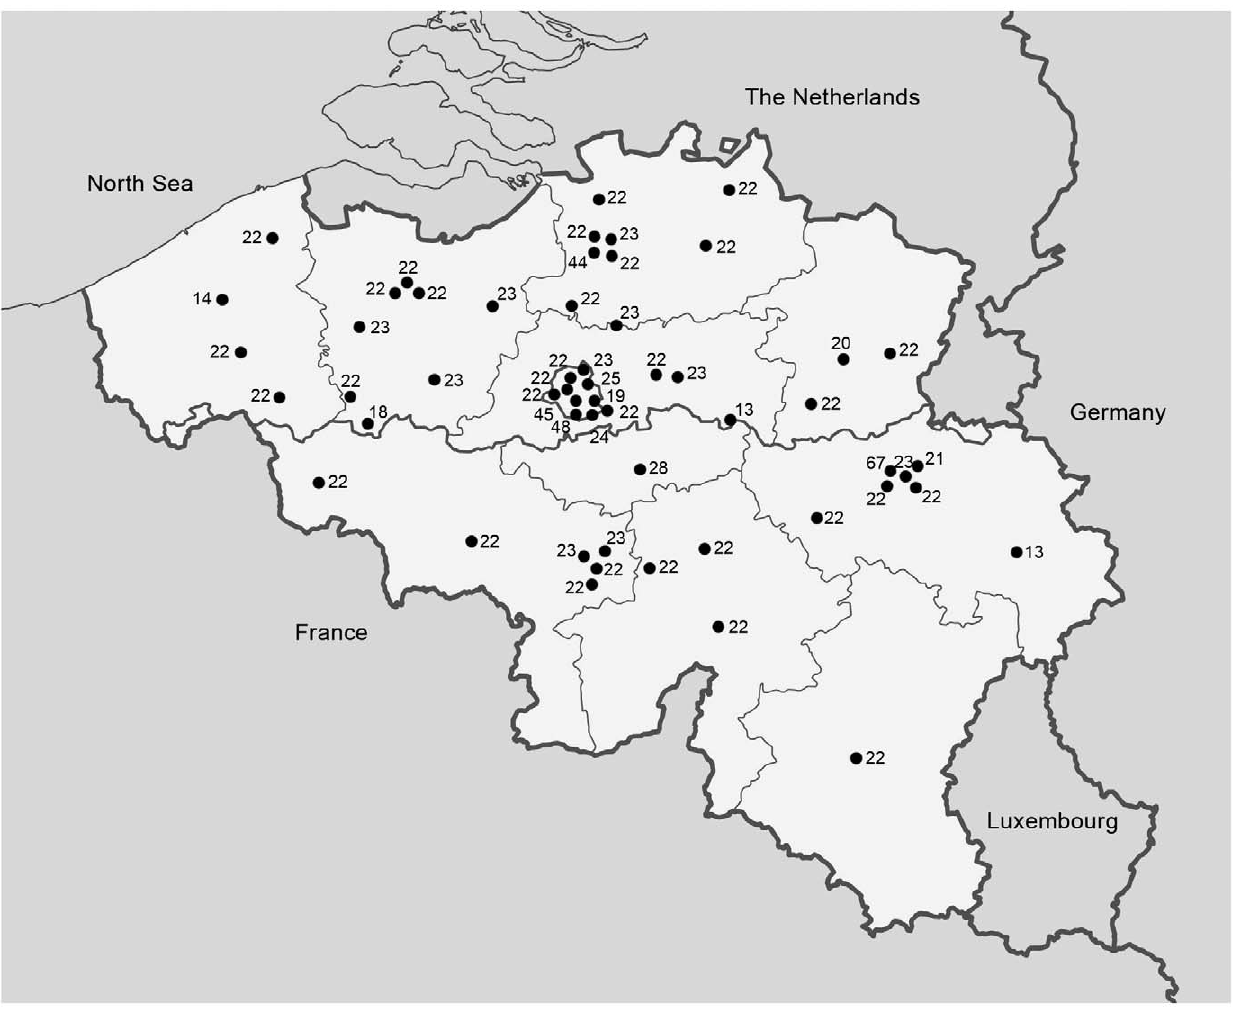
Figure 1. Geographical distribution of the 55 hospitals visited in Belgium and the number of pregnant women (n=1311) investigated by site (national survey on vitamin D status of pregnant women Belgium 2010–2011).